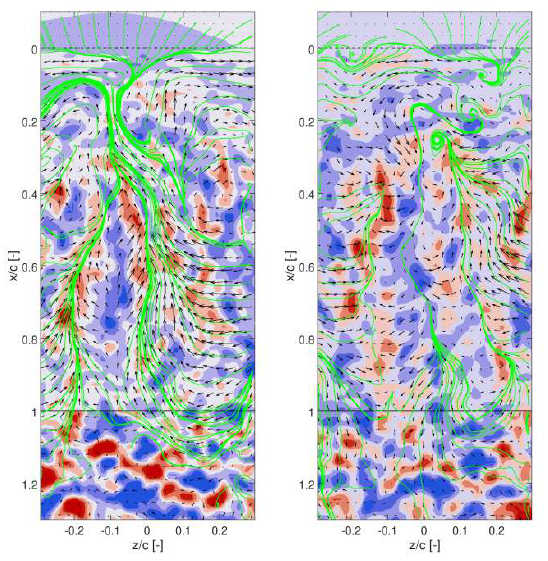
Fig. 10. Spanwise slices of plane y w /c = 0.01 m . Velocity POD modes no. 3 (left) & 5 (right). Content 2.5% & 2.3% of